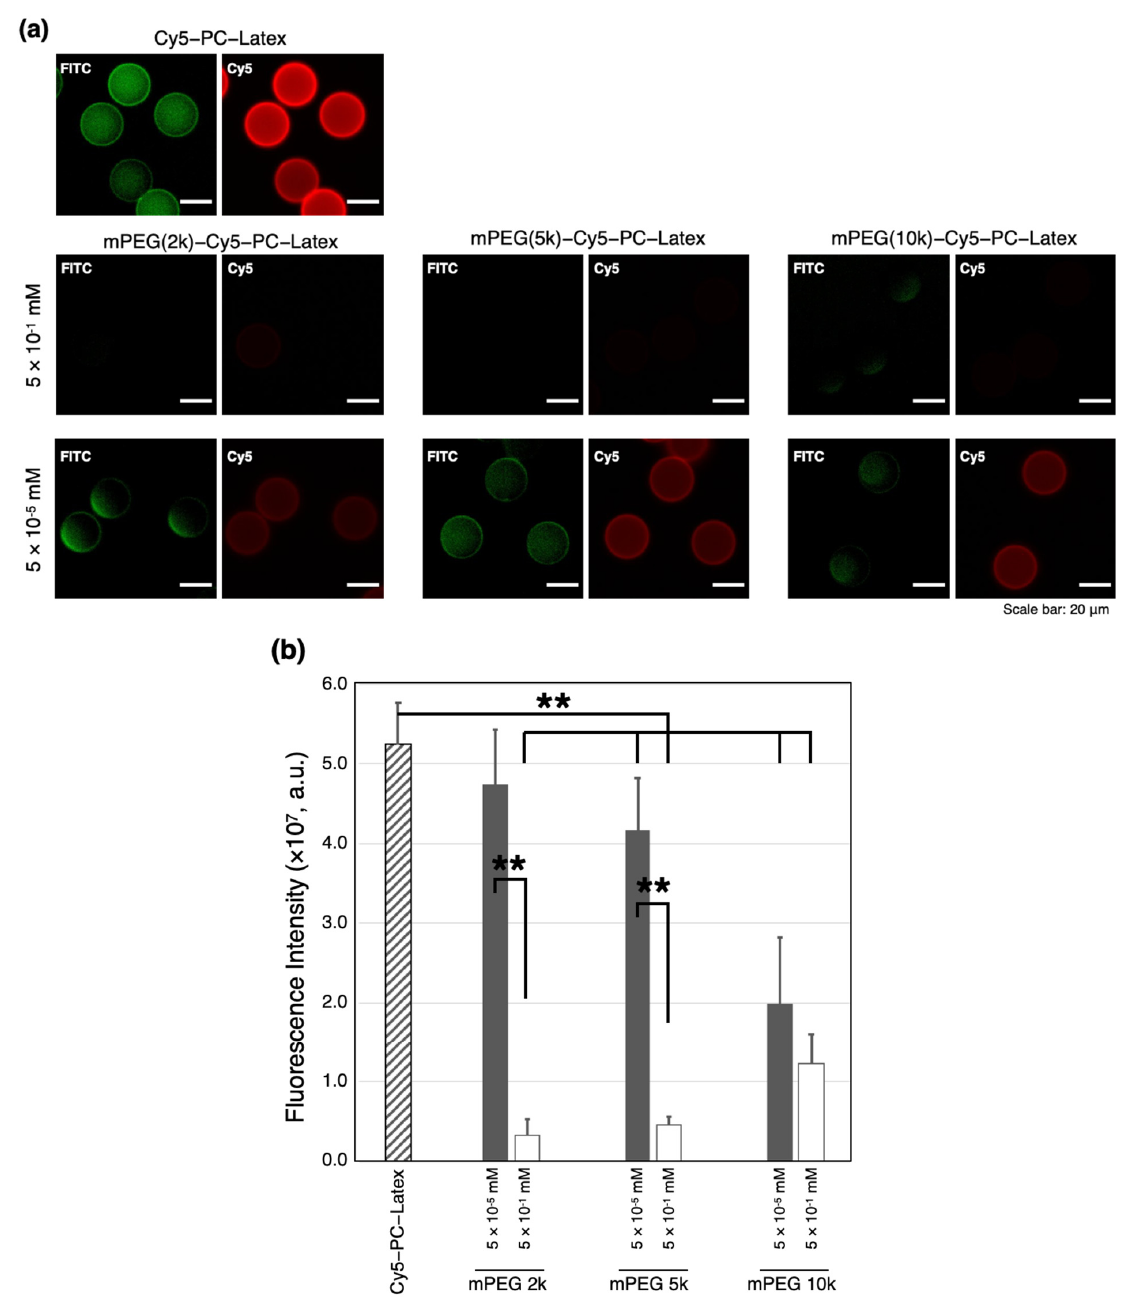
Figure 4. FITC-Albumin absorbance of Cy5-PC-Latex beads and mPEG(2K, 5K, 10K)-Cy5-PC-Latex beads. ( a ) Raw fluorescence images obtained via fluorescence microscopy. Green: FITC-Albumin; Red: Cy5. Scale bar indicates 20 μ m. ( b ) Fluorescence intensity of FITC-Albumin adsorbed onto the beads. Data was acquired from fluorescence microscope images (N = 10). ** p < 0.01 indicate significance. Error bars indicate standard deviation.